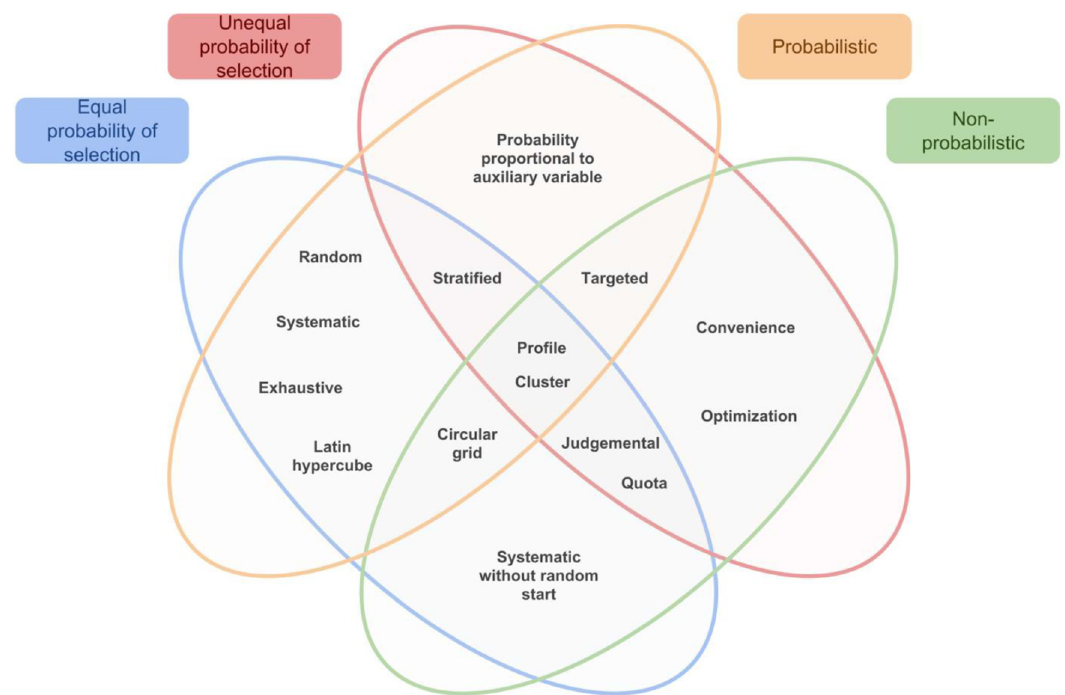
Fig. 4. Sampling design Venn